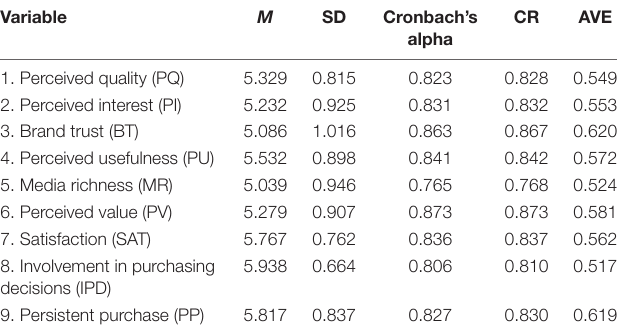
TABLE 3 | Variable description, reliability, and validity.